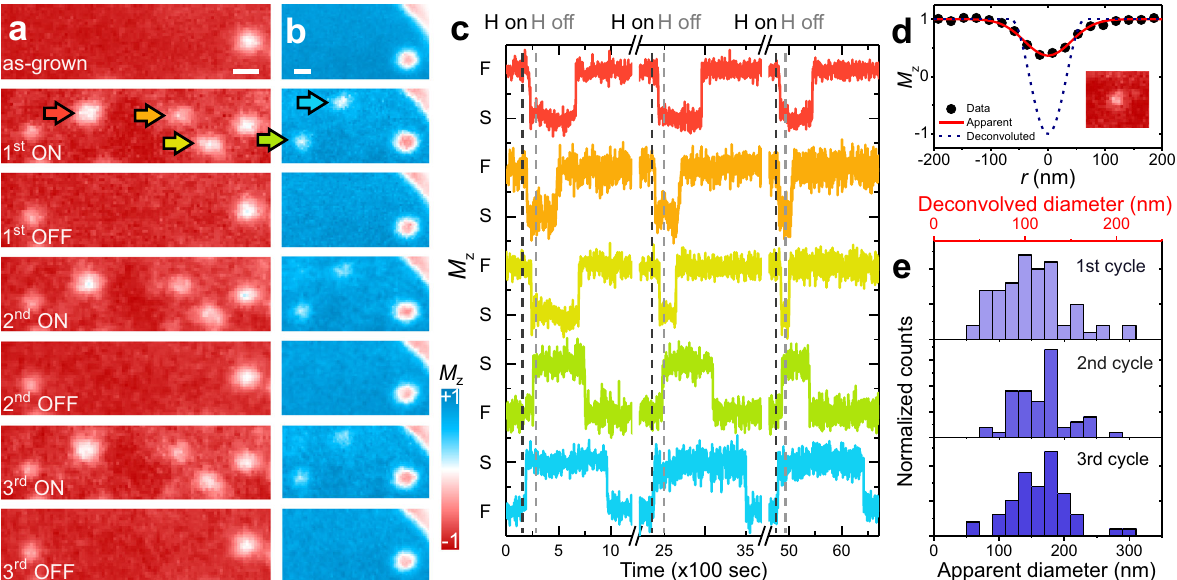
Fig. 3 Reversible writing/deleting of magnetic skyrmions. a SPLEEM images of perpendicularly magnetized domains in Ni/Co/Pd/W(110), showing reversible skyrmion writing/deleting over three hydrogen ON/OFF cycles (indicated by the red, orange and yellow arrows), scale bar is 200 nm. b Similar time sequence as panel a , here on a + M z domain (blue), showing reversible writing/deleting of two skyrmions (green and blue arrows), scale bar is 200 nm. c Time-dependent M z evolution at the center of skyrmions highlighted by the arrows in panels a and b over three hydrogen ON/OFF cycles, showing reversible skyrmion switching between ferromagnetic state (F on y axis) and skyrmion state (S on y axis). Color of the curve corresponds to the arrow color. d M z pro fi le of a skyrmion (see inset) and its deconvolved pro fi le in ideal imaging condition. e Histograms of skyrmion diameters (lower scale image-apparent, upper scale deconvolved measurements) over three cycles of H ON/OFF.